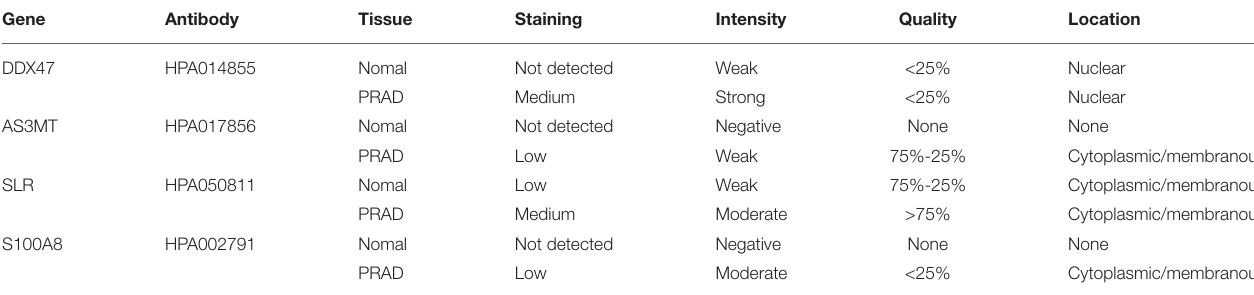
TABLE 2 | IHC validation in